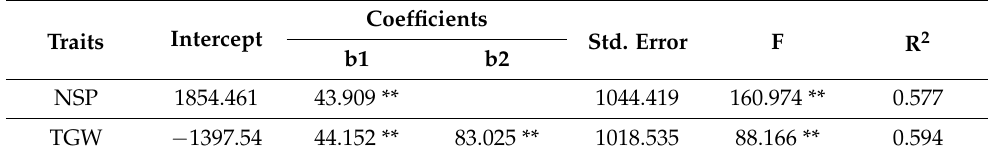
Table 1. Results of stepwise regression of grain yield per hectare as a dependent variable and other traits as the independent variables in the F8 population resulting from Gonbad × Zagros in 2020.